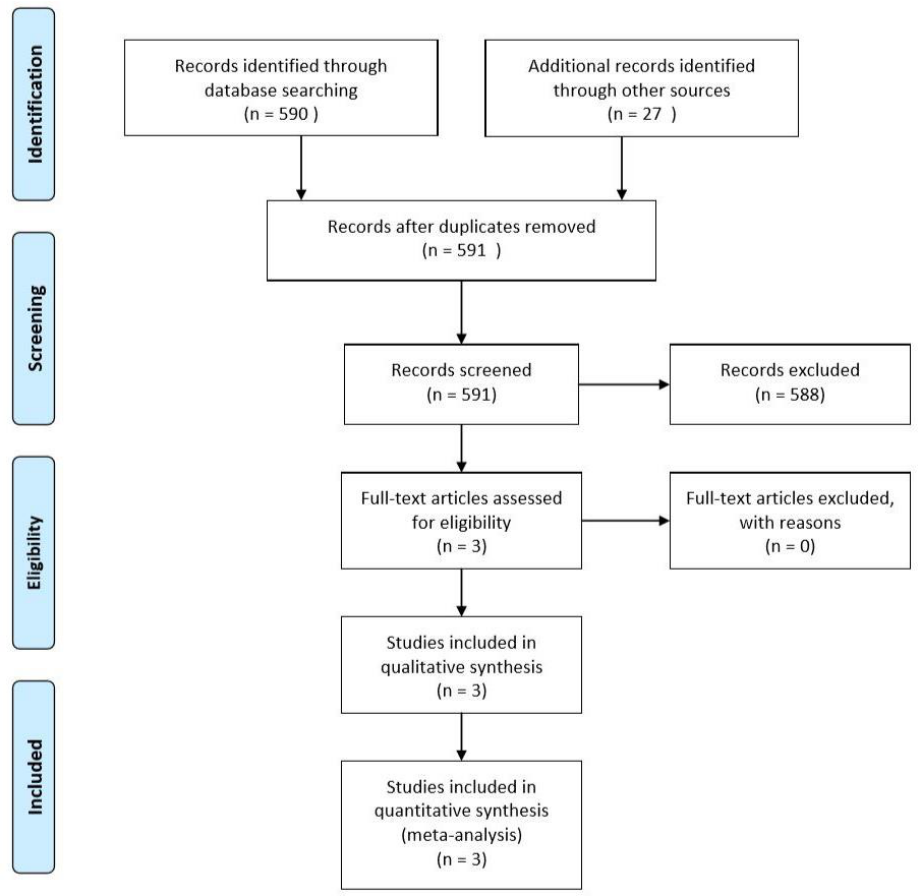
Figure 1. Flow diagram (PRISMA format) of the screening and selection process.